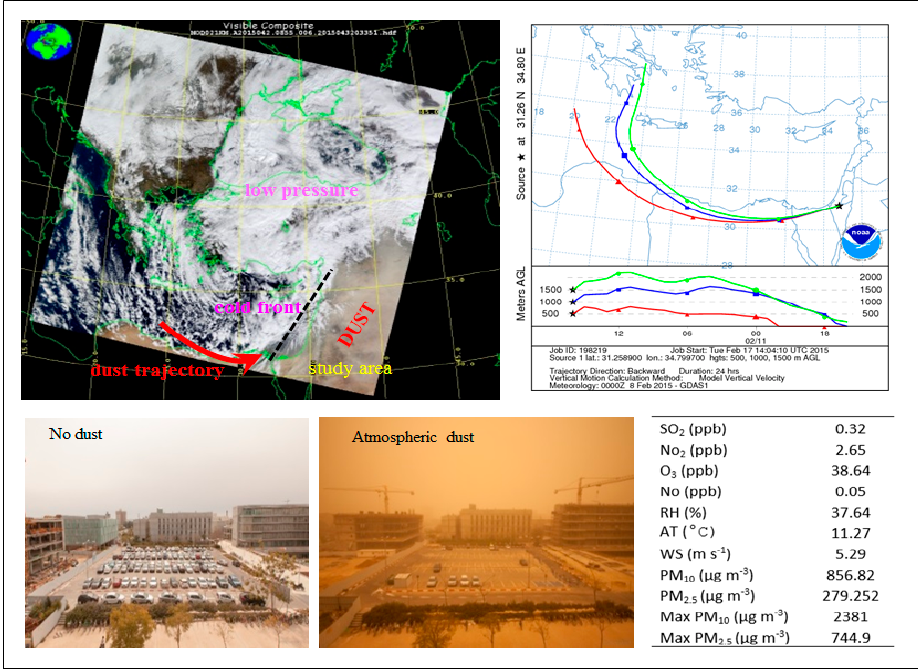
Figure 2. Satellite images (MODIS) of the study region during the dust storm of 11 February 2015, along with air mass transport at different heights above ground level (AGL). In the lower panel: daily recorded averages of major meteorological variables and pollutants measured in the environmental monitoring station of Beer Sheva during the dust event of 11 February 2015. AT—air temperature; RH—relative humidity; WS—wind speed; PM—particulate matter. The two photos were taken in the same location, the campus of Ben Gurion University (Beer Sheva), during a non-dust day (left) and during the dust event of February 2015 (right) in the study